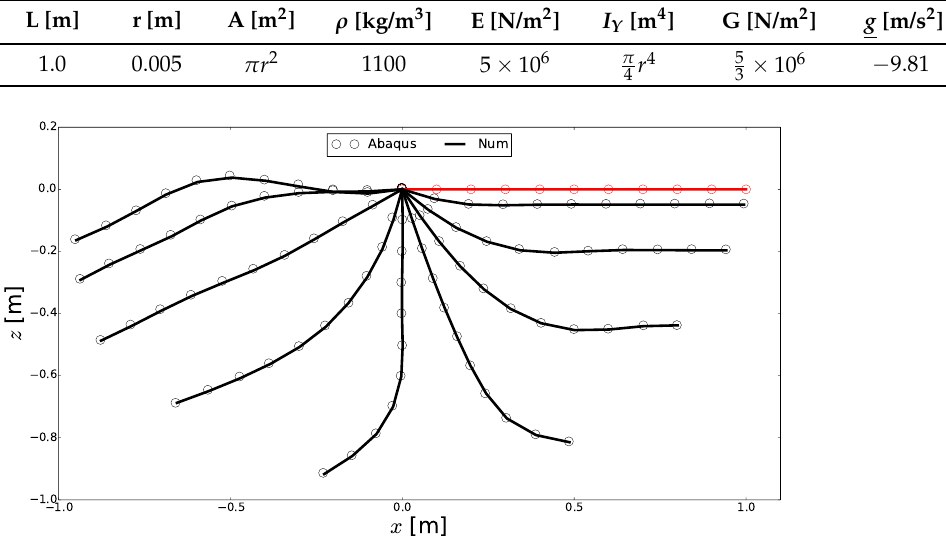
Table 5. Geometrical and material properties of the swinging elastic rod.